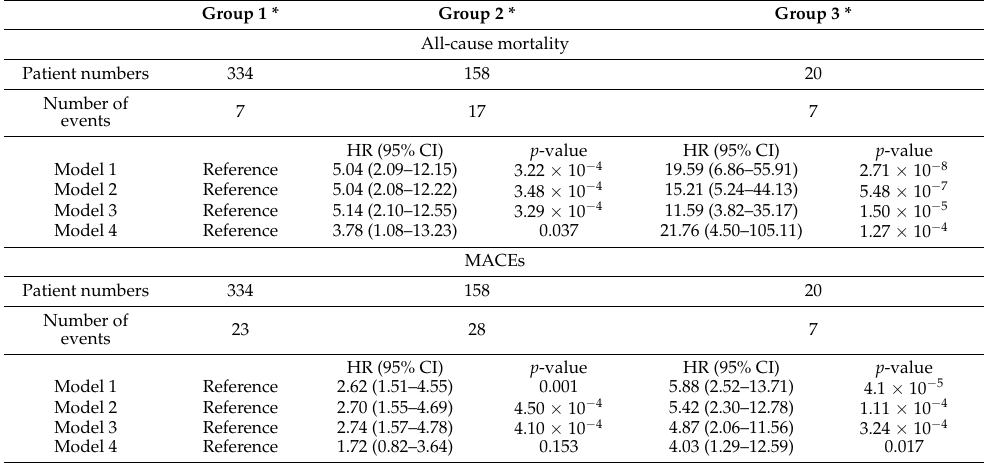
Figure 5. Kaplan–Meier curve analysis of combining resistin and sST2 levels with corresponding WGRS in predicting freedom from all-cause mortality ( A ) and freedom from MACEs ( B ) in the patients with CAD. WGRS, weighted genetic risk scores; MACEs, major adverse cardiac events. Group 1: patients without high resistin levels/low RETN WGRS and high sST2 levels/low IL1RL1 WGRS; Group 2: patients with either high resistin levels/low RETN WGRS or high sST2 levels/low IL1RL1 WGRS; Group 3, patients with both high resistin levels/low RETN WGRS and high sST2 levels/low IL1RL1 WGRS. Table 3. Cox regression analysis of all-cause mortality and MACEs rate between the groups strati- fied by the presence of high resistin level/low RETN WGRS and high sST2 levels/low IL1RL1 WGRS.